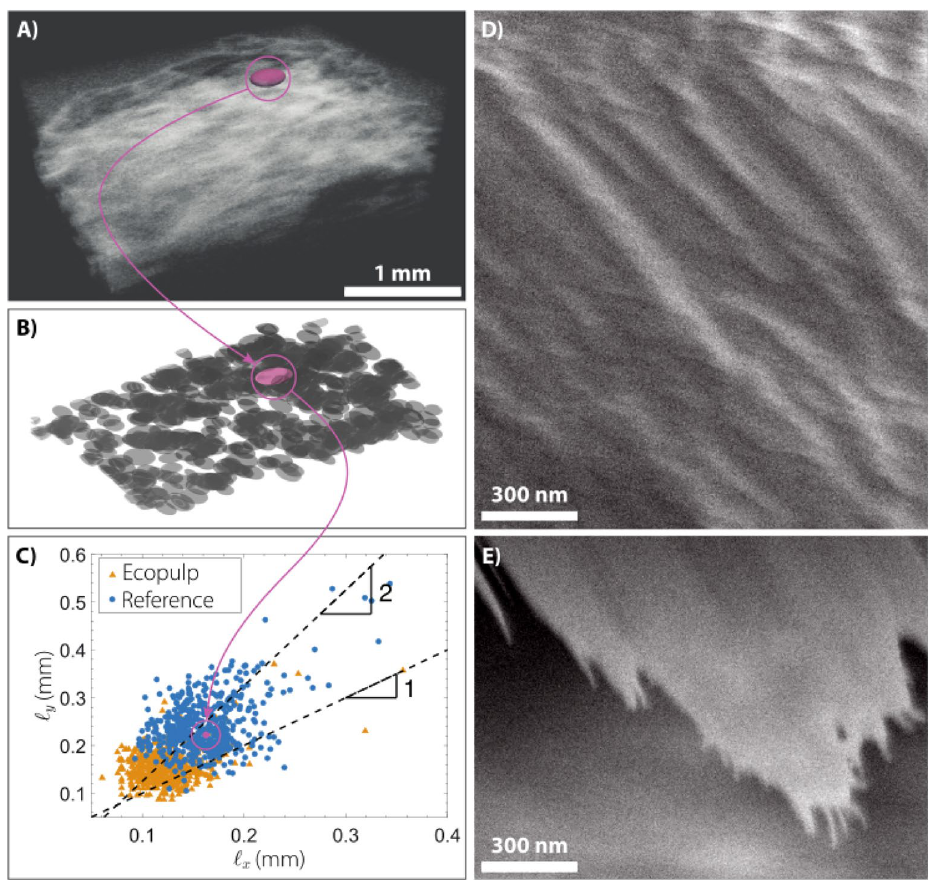
Figure 2. Structure of wood-mimicked foams. Microscopy image of a foam rod. ( A ) Reconstruction of the OCT signal provides a 3-dimensional internal structure of a single rod. The solid structure is shown in white making it appropriately transparent for clarity. ( B ) Visualization of the larger pores inside the rod represented with ellipsoids (negative space of A ). ( C ) Pore dimensions ℓ x vs. ℓ y . Black dashed line represents ℓ x correlation ℓ y > ℓ x implies that the pores are elongated along the rod axis. ( D ) The fiber structure was explored by using Scanning Electron Microscopy. A high magnification over the solid structure of the foam block shows an oriented ridged distribution. ( E ) The nearby edge of the torn film has whiskers (white) oriented along the structures seen in Panel ( D